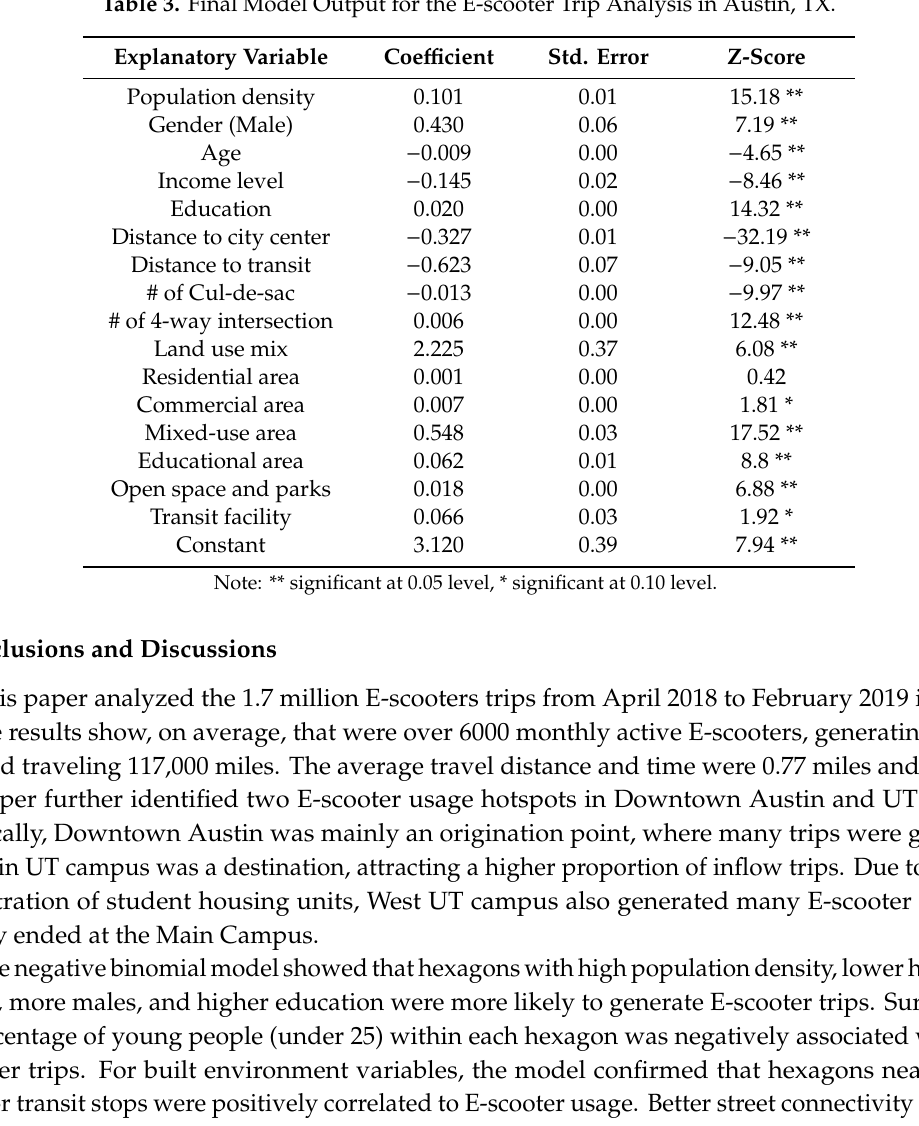
Table 3. Final Model Output for the E-scooter Trip Analysis in Austin, TX. Explanatory Variable Coe ffi cient Std. Error Z-Score Population density 0.101 0.01